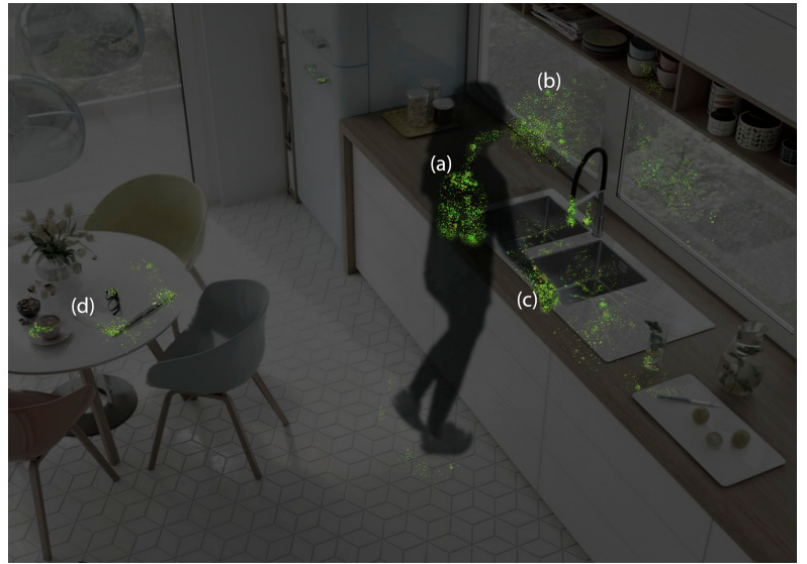
Figure 2. Conceptualization of SARS-CoV-2 deposition: ( a ) once infected with novel coronavirus, viral particles get in the lungs and upper respiratory tract; ( b ) transmission of SARS-CoV-2 via droplets and aerosolized viral particles when COVID-19 patients talking, coughing, breathing, singing, and sneezing and can distribute on the other people’s nose, mouth, eyes, clothes, and nearby surroundings; ( c ) SARS-CoV-2 from the mouth and nose is often observed on the hands; and ( d ) SARS-CoV-2 could be distributed to often touched surfaces and objects [63].